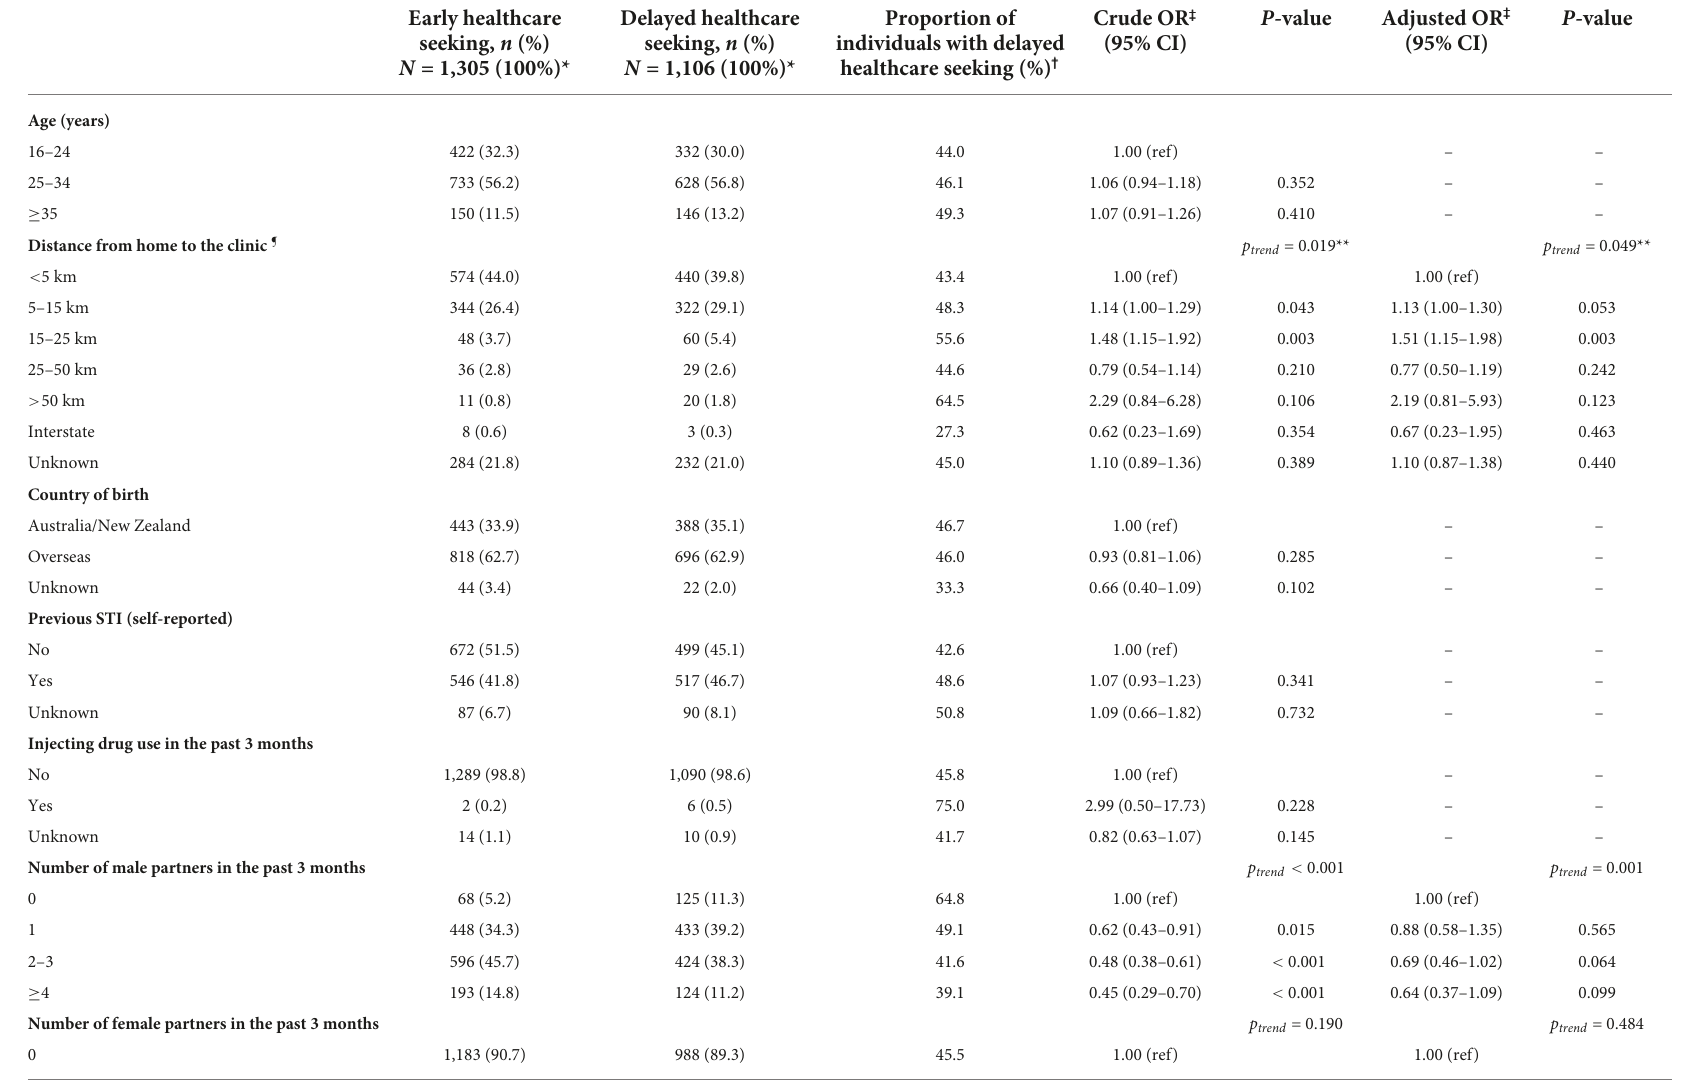
TABLE 3 Factors associated with delayed healthcare seeking ( > 7 days) among 2,411 symptomatic women attending the Melbourne Sexual Health Centre, 10 August 2017 to 31 December